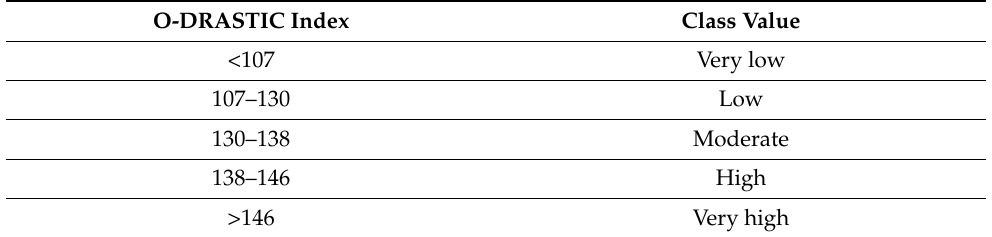
The O-DRASTIC index is classified into five vulnerability levels (Table A2): Table A2. O-DRASTIC